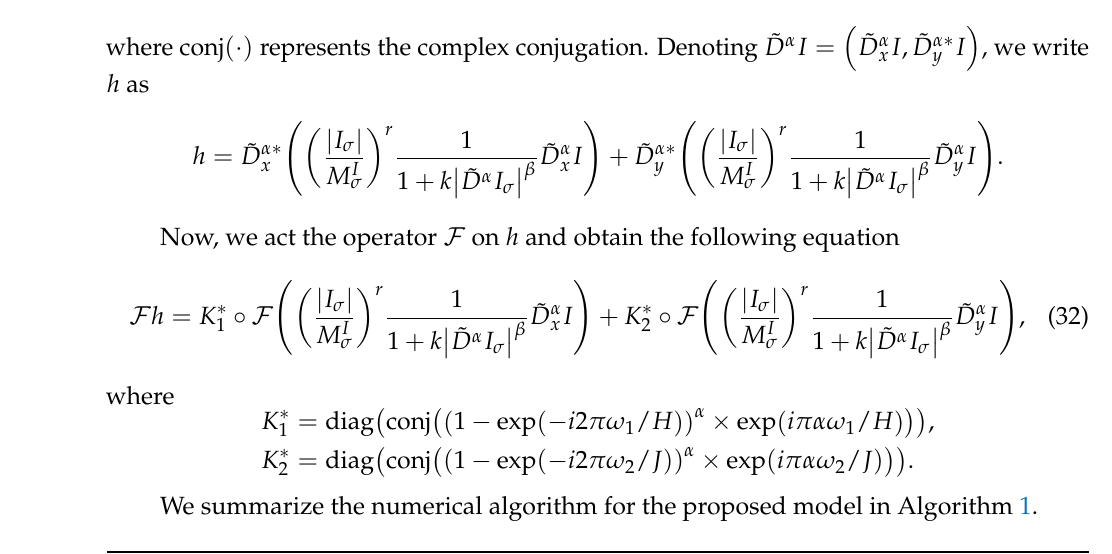
Algorithm 1 DFT-based algorithm of the proposed